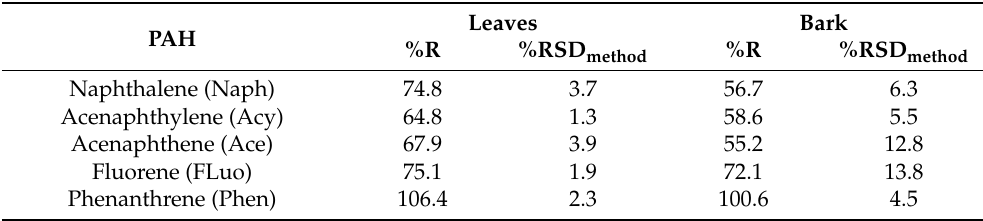
Table 3. Percentage recoveries (%R) and method repeatability expressed in terms of percent relative standard deviation (%RSD method